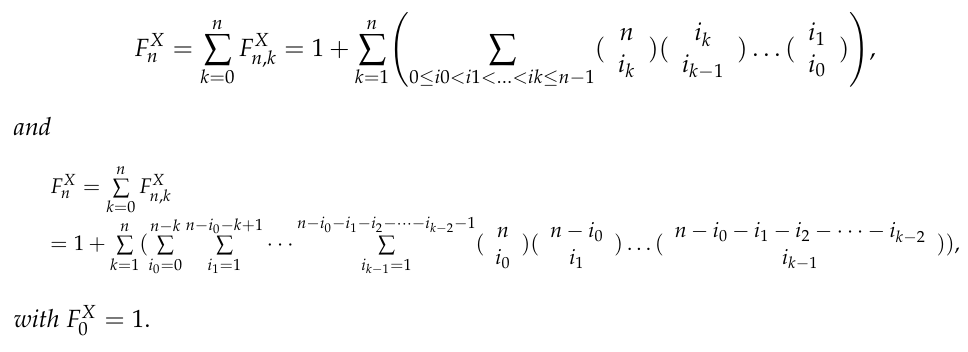
(cid:16) (cid:17) ∅ = F X ; k and F n , k n , k